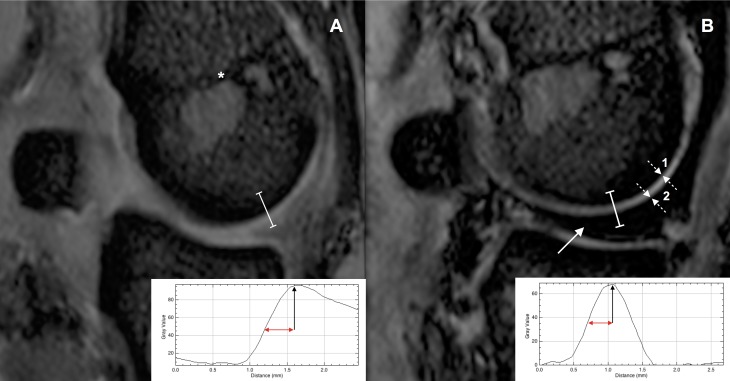
Particle dependent MRI signal and histologic findings.Sagittal T2*W MR images of a porcine metacarpo(tarso)phalangeal joint before (Panel A) and after (Panel B) SPION injection and joint cycling. Graph-inserts show the grey scale intensity plot profile measured along a line (white) through the midpoint of the condyle and at 90° to the physis (*). Bar = 50 μm. Following intra-articular injection resulting in hypointense filling of the joint (white arrow) and particle permeation, peak intensity grey scale levels of cartilage associated MRI signal (black arrow in graph insert) are reached at a shorter distance from the subchondral bone plate (number 1 in figure) suggestive of superficial signal change. This was assessed by measuring the distance between the “peak” and “half-peak” intensity grey scale point on the profile plot (red arrow in graph insert) and comparing this pre- and post nanoparticle administration. The cartilage surface is indicated by the number (2) in the figure.